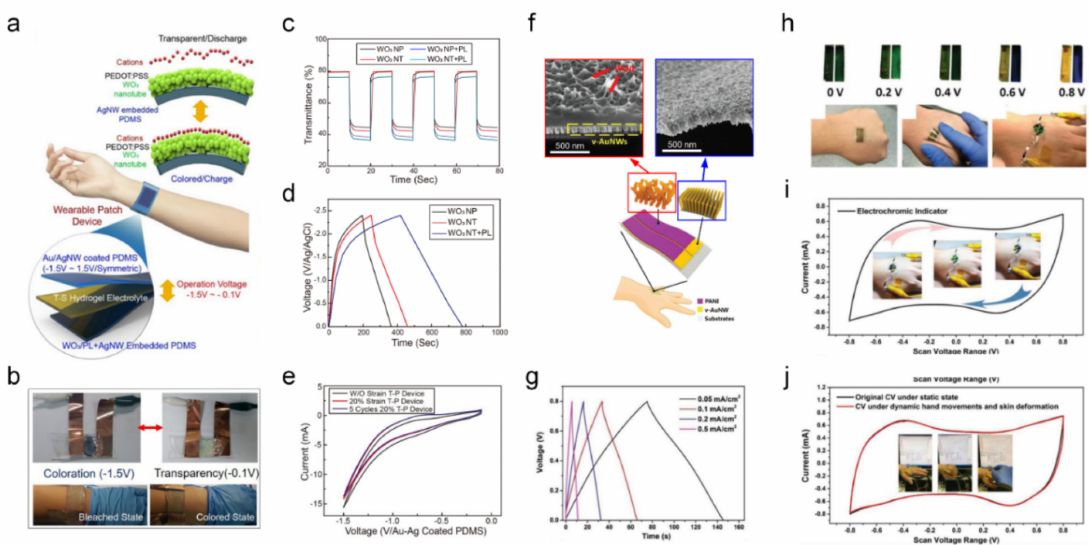
Figure 5. EC energy storage devices with the capability of visual charge level inspection (( a – e ) adapted with permission ref. [6], copyright 2019 American Chemical Society, ( f – j ) adapted with permission ref. [58], copyright 2018 Wiley-VCH Verlag GmbH & Co.). ( a ) Operation schematic of an all-transparent stretchable EC supercapacitor (all-TSES). ( b ) Coloration (discharged state) and bleaching (charged state) of the all-TSES under normal and stretched states. ( c ) Transmittance change of various WO 3 nanostructures consisting of the all-TSES. (PL: PEDOT: PSS Layer) ( d ) Galvano- static charge–discharge (GCD) graphs of the all-TSES with three variations of the nanostructure combination ( e ) CV result of 20% stretched all-TSES devices. ( f ) Structural diagram of a wearable EC supercapacitor and its vertical gold nanowire (v-AuNWs) structure evaluated by SEM. ( g ) GCD curves of a v-AuNW/PANI supercapacitor under varied areal current densities. ( h ) EC properties of v-AuNW/PANI-based supercapacitor with different charge levels and under conditions required for flexibility. ( i ) CV curve with the photograph of EC change. ( j ) CV curves of the v-AuNW/PANI supercapacitor comparing the dynamic condition with the static